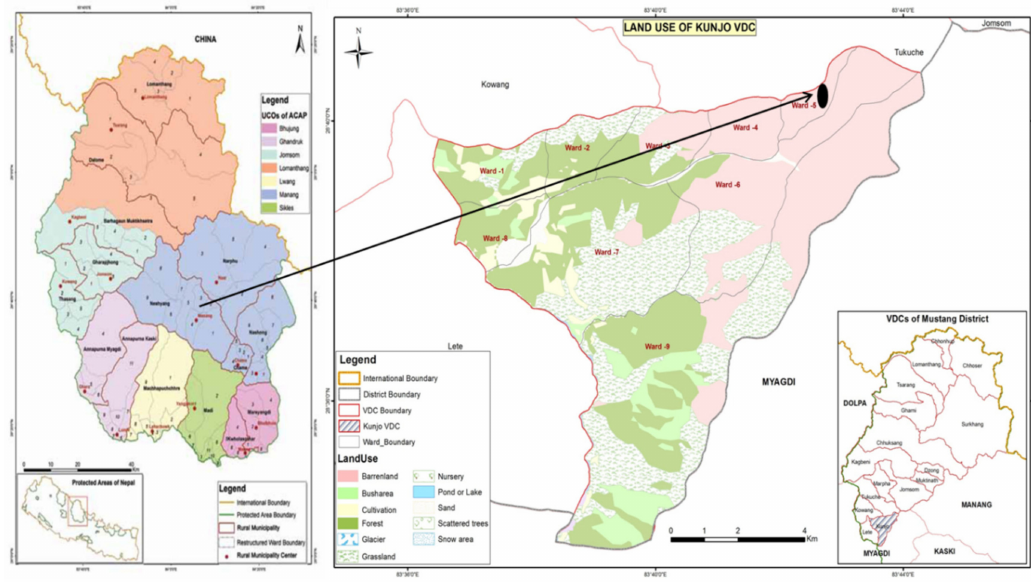
Figure 1. Location of the ACAP (Annapurna Conservation Area Project) area in